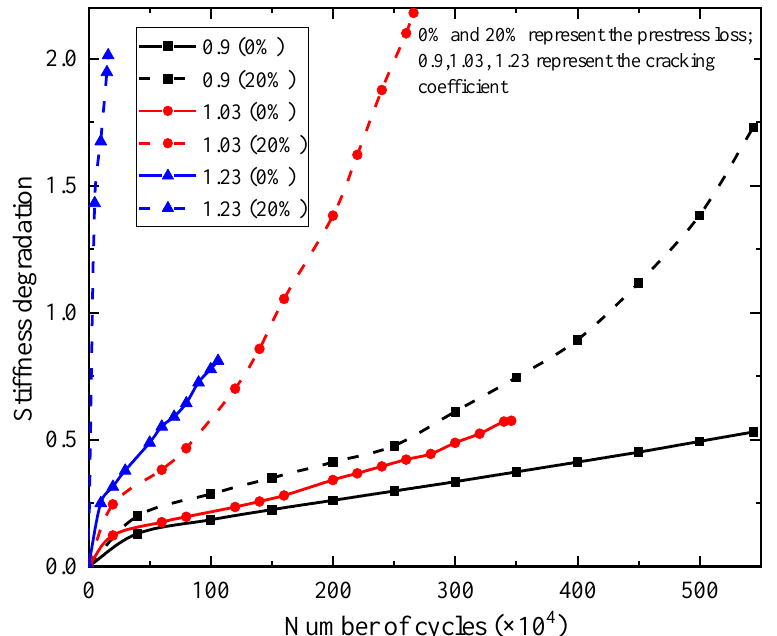
Figure 25. The effect of the fatigue load level and the prestress loss on the stiffness degradation of the beams.